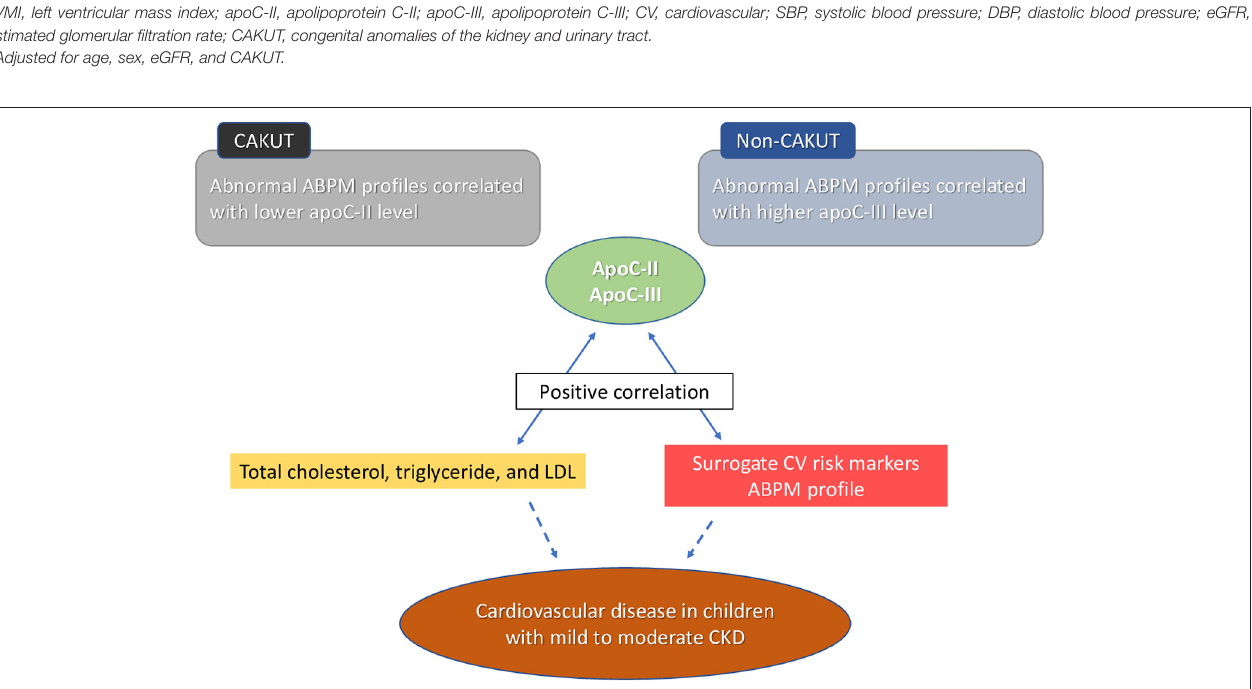
FIGURE 2 | Plasma apolipoprotein C-II and C-III levels have a positive correlation with lipid profile, including total cholesterol, triglyceride, and low-density lipoprotein (LDL). Plasma apolipoprotein C-II and C-III levels have a positive correlation with surrogate cardiovascular (CV) risk markers. Abnormal ambulatory blood pressure monitoring (ABPM) profile was associated with lower apoC-II level in congenital anomalies of the kidney and urinary tract (CAKUT) patient and higher apoC-III levels in non-CAKUT patients. These correlations suppose a negative impact of apolipoprotein C-II and C-III on cardiovascular risk in the early stages of childhood chronic kidney disease